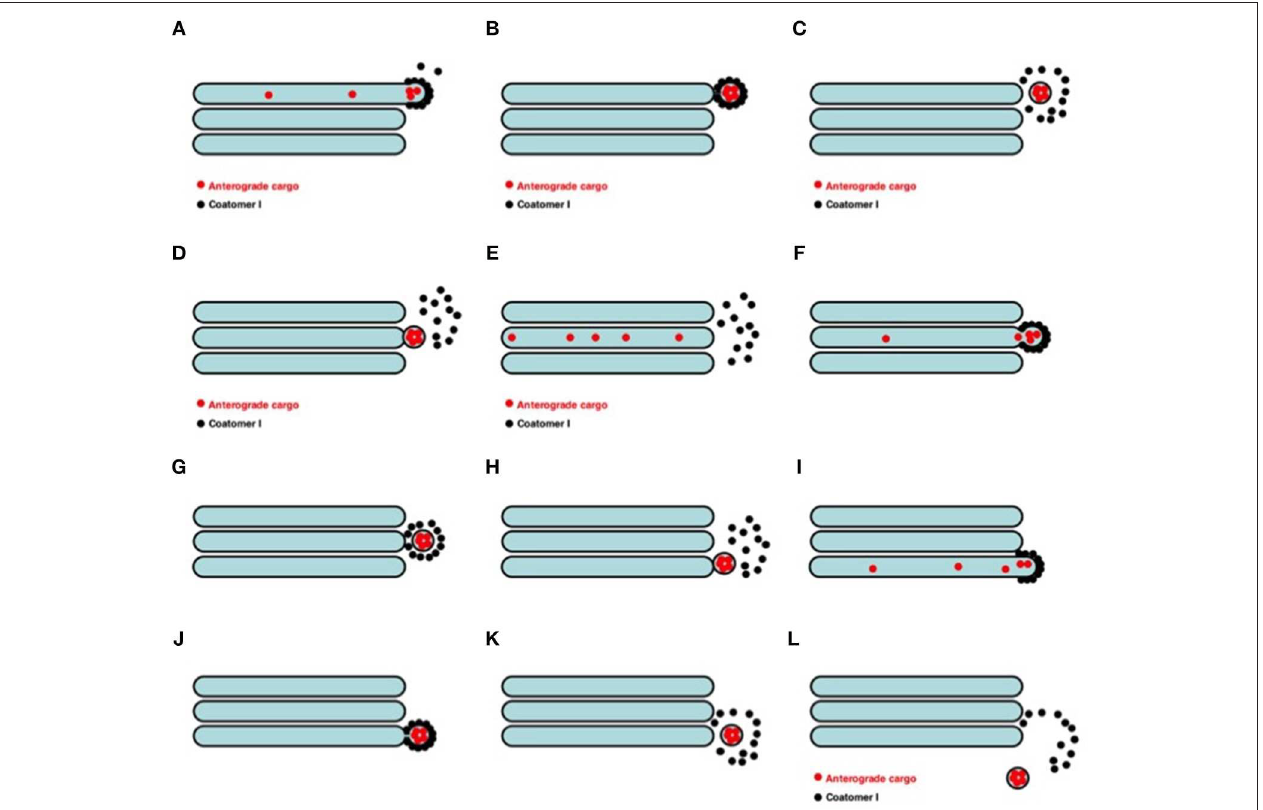
FIGURE 5 | Scheme of the VM for intra-Golgi transport (see also movie https://yadi.sk/i/M1ykjxKabmjs5). (A) COPI (black dots) forms a coat on a membrane bud. A cargo (red dots) is concentrated inside the COPI-coated bud. (B, C) This bud undergoes detachment (B) and uncoating (C) . (D) The vesicle fuses with the distal Golgi compartment. (E) Distribution of the cargo within the next Golgi cisterna. (F–H and I–L) Repetition of the first stage. Finally, the vesicle can move out the Golgi (L) .